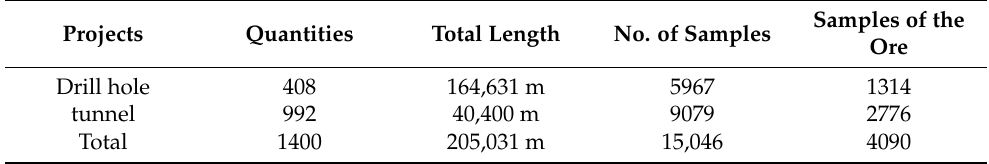
Table 1. Exploratory operations statistics